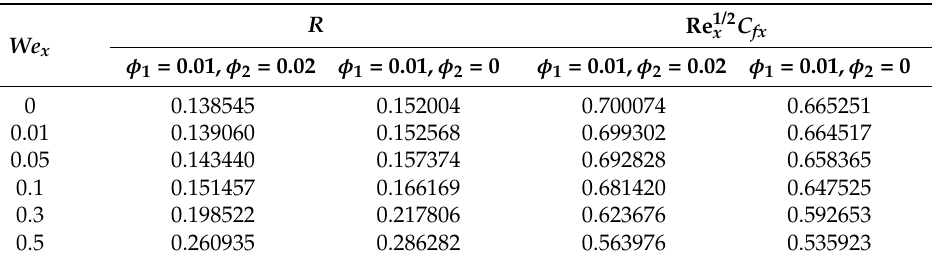
Table 4. As the local Weissenberg number We x undergoes variation, numerical approximations are made for the values of both the dimensionless film thickness or R and the local skin friction coefficient Re 1/2 x C fx . These approximations are based on specific parameters including m = 1.4, ε = 0.8, Pr = 7, S = − 1 and M = 1.2.